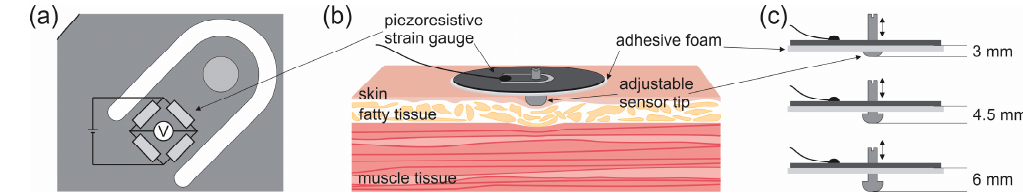
Figure 1. Muscle contraction (MC) sensor design and placement. ( a ) Four piezoresistors, connected in Wheatstone bridge, were attached at the root of the tonguelet. Piezoresistors contact pads and cable interface were connected with microelectronic golden wires and covered with epoxy casting compound for protection. ( b ) The sensor was attached to the skin through the supporting part using double-sided adhesive patches. ( c ) The depth of the sensor tip was set to 3, 4.5 and 6 mm. The sensor compressed the skin and subcutaneous tissue, exerting pressure on the measured skeletal